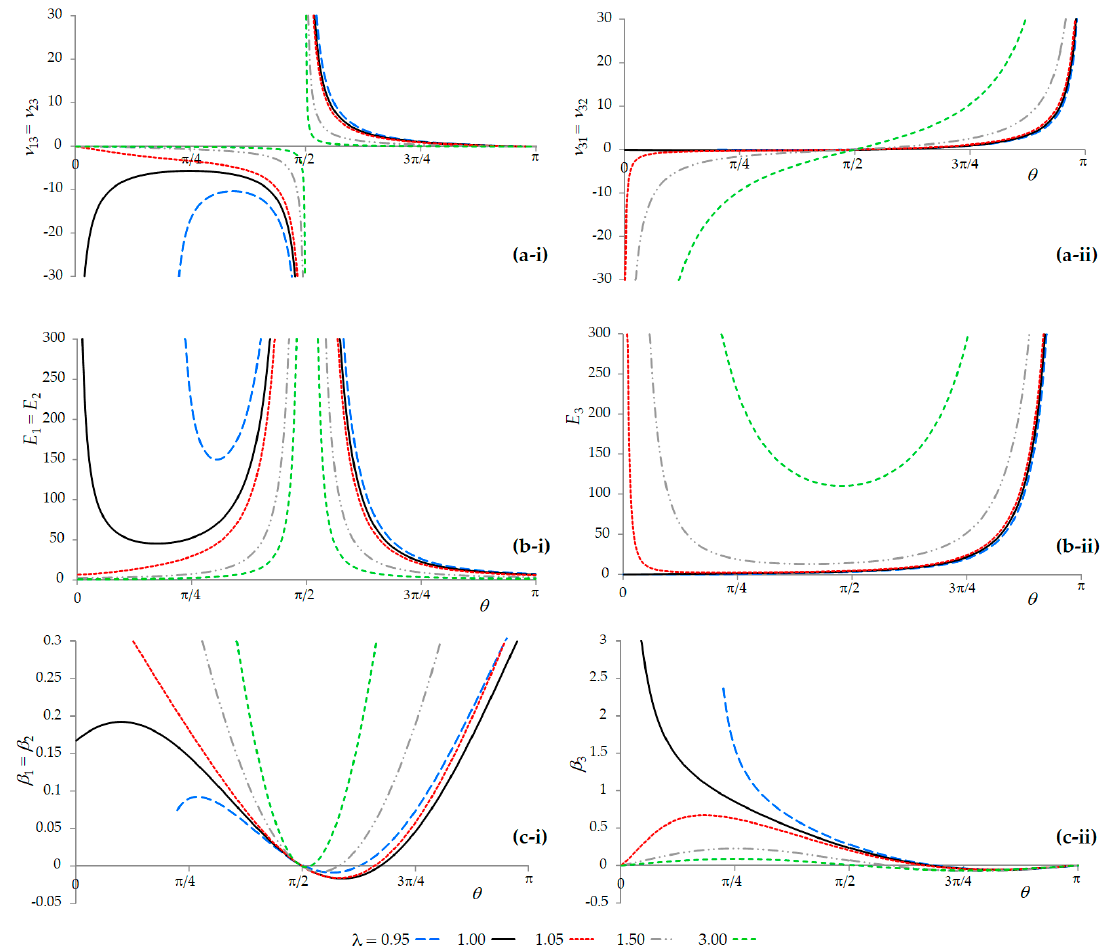
Figure 3. Plots of ( a ) the Poisson’s ratio in the Ox 1 – Ox 3 and Ox 2 – Ox 3 planes for loading in (i) the Ox 1 or Ox 2 direction and in (ii) the Ox 3 direction; ( b ) the Young’s moduli in (i) the Ox 1 or Ox 2 direction and in (ii) the Ox 3 direction; and ( c ) the linear compressibility in (i) the Ox 1 or Ox 2 direction and in (ii) the Ox 3 direction. Note that negative Poisson’s ratios in the Ox 1 – Ox 3 and Ox 2 – Ox 3 planes are always present when θ is less than π / 2, whilst negative compressibility is present when θ is greater than π / 2. Note that for these plots, k ϕ and k ϕ were arbitrarily chosen as ½ and 1, respectively, whilst l was set as 1. Units are arbitrary.